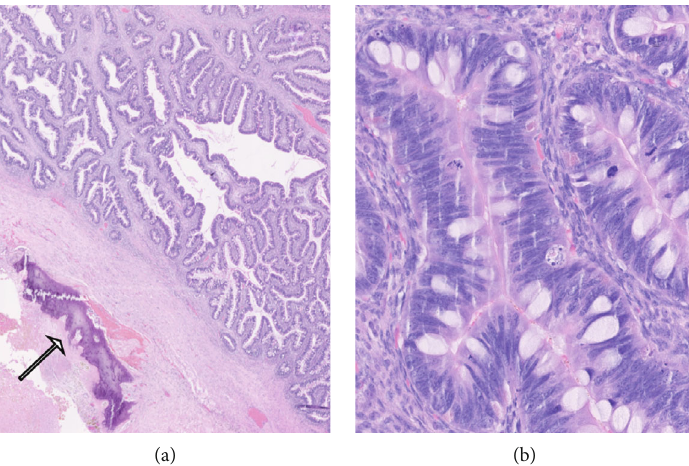
Figure 2: Pathologic aspects of the ovarian intestinal-type mucinous carcinoma at low power view. Note the presence of residual bone tissue (arrow) (a). At a high power view, the glands are lined by columnar and goblet cells with moderate atypia and brisk mitotic activity (b).